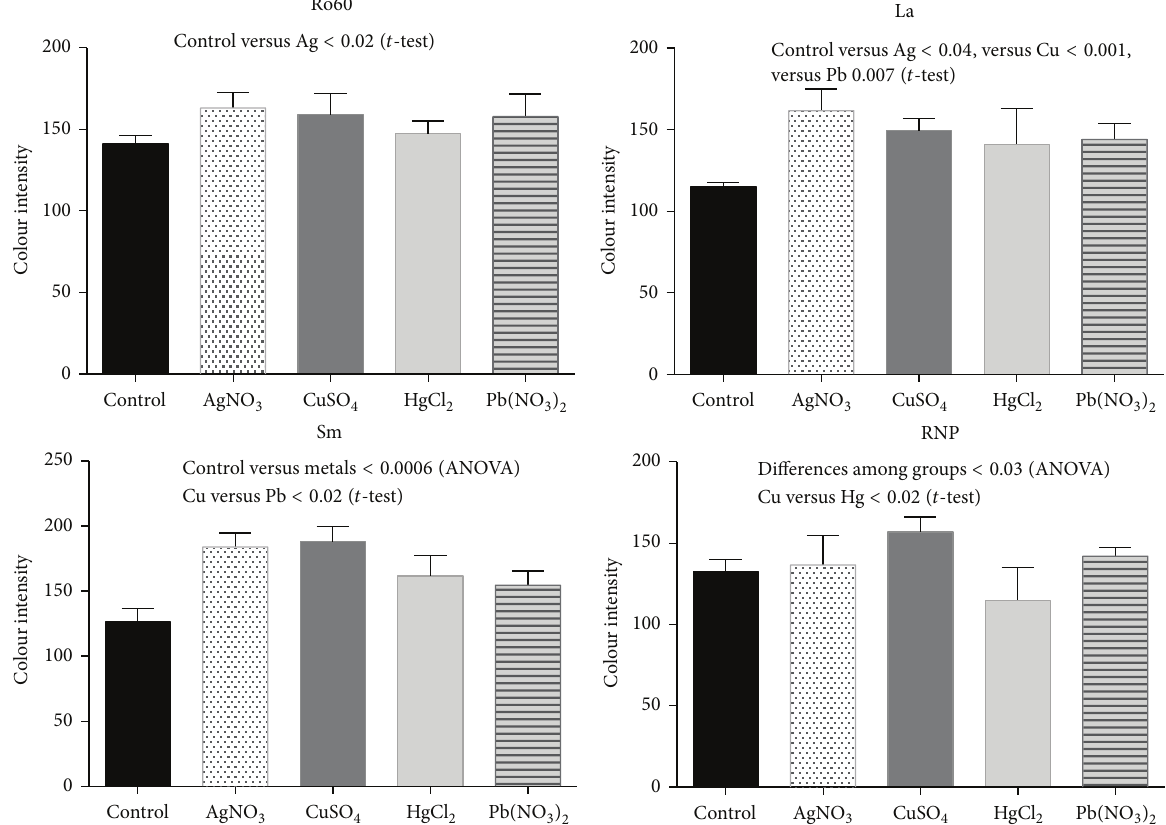
Figure 6: Ribonucleoprotein expression by immunohistochemistry of kidneys. The graphs (mean and SD) express the intensity of the color reaction obtained demonstrating the overexpression of some ribonucleoproteins induced by heavy metal